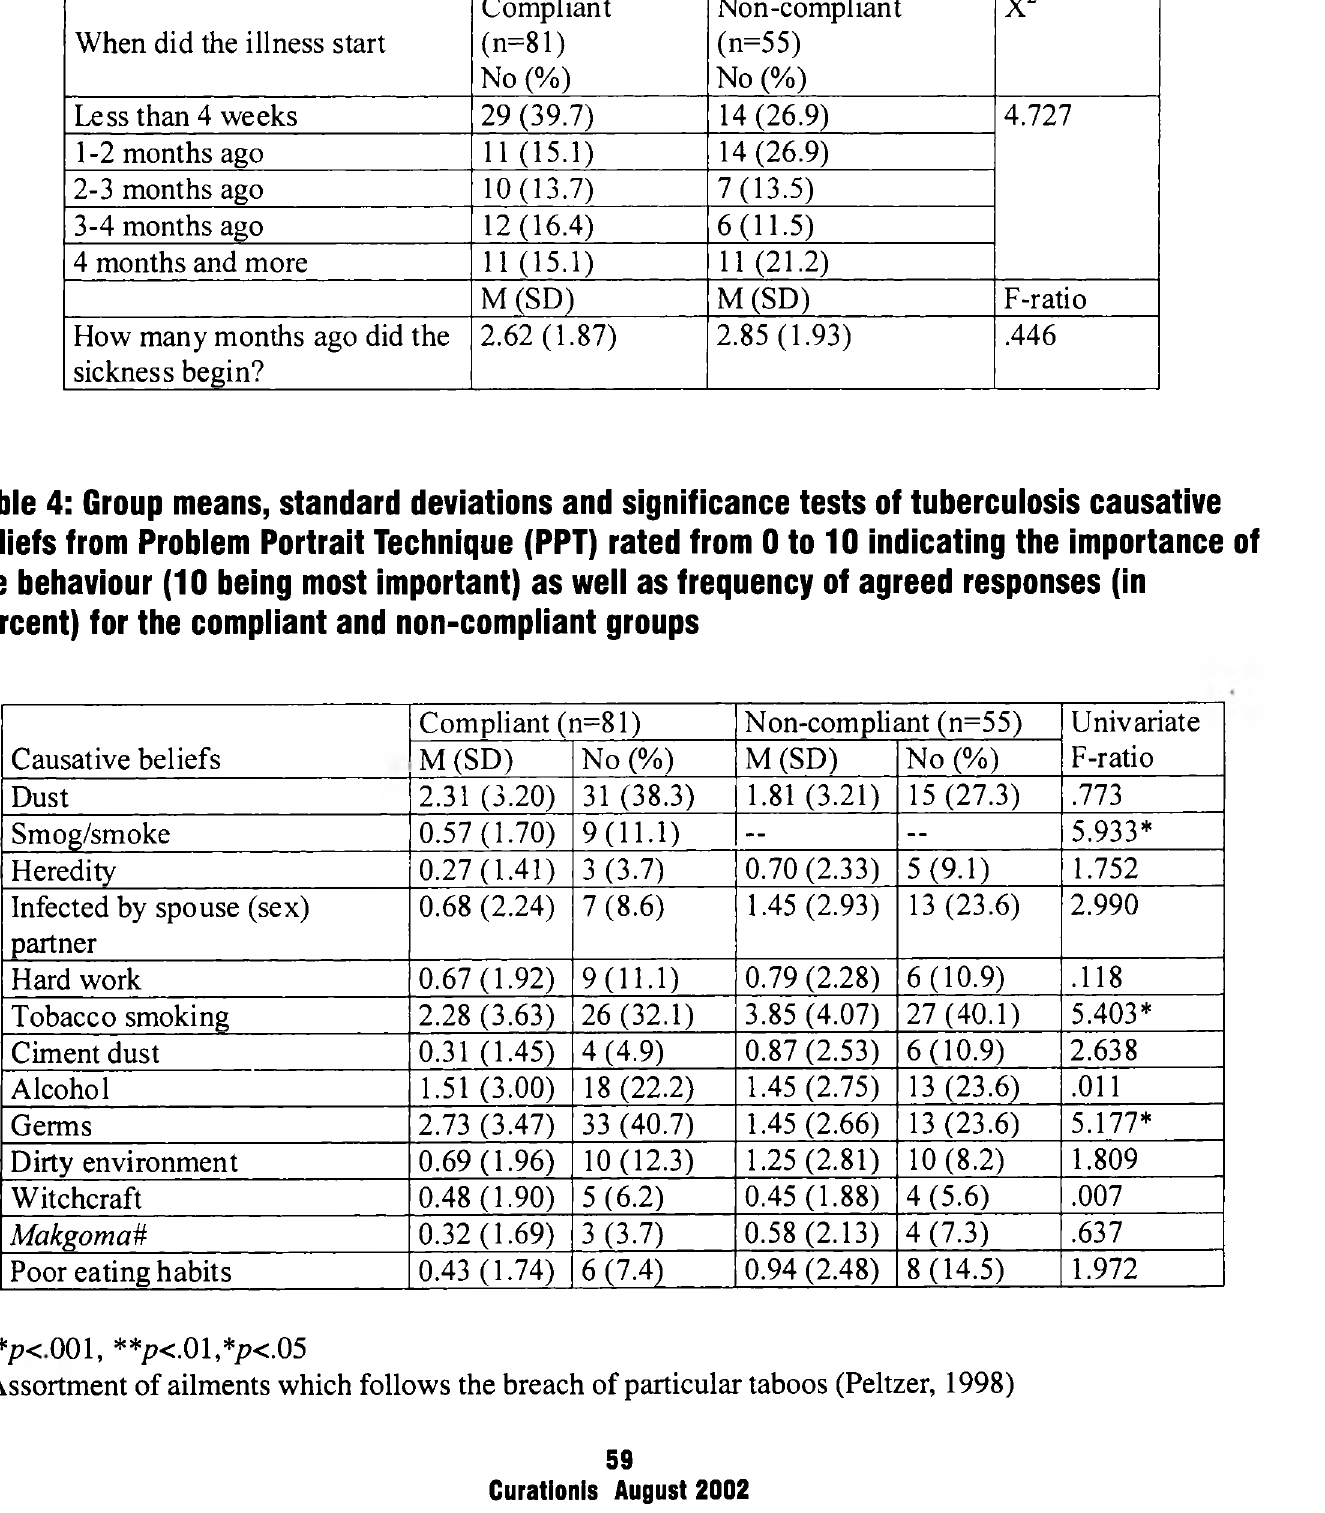
Table 3: Onset of tuberculosis for the compliant and non-compliant groups